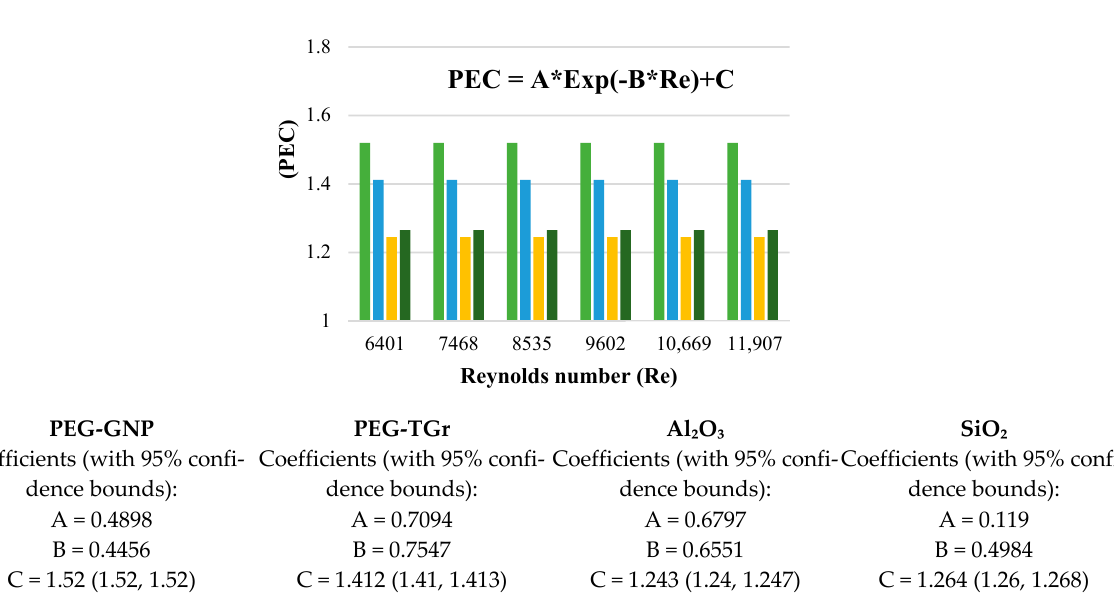
Figure 10. PEC of different nanofluids against Reynolds number.